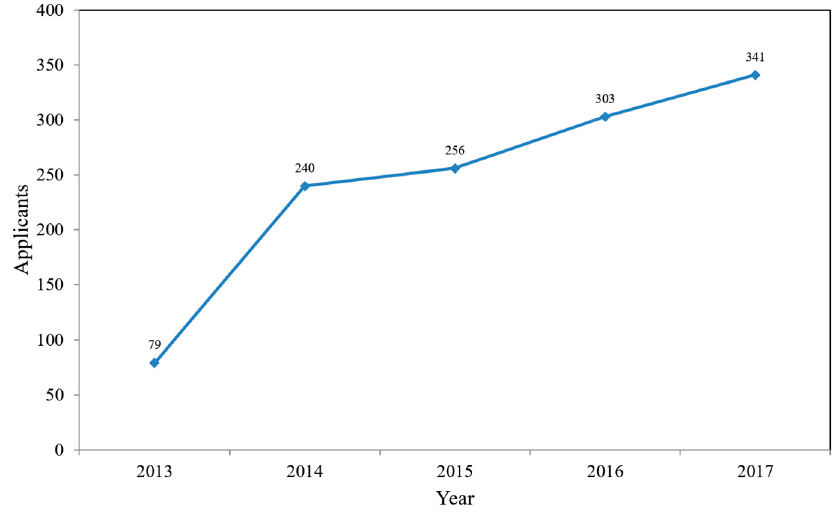
Figure 1. Growth of the number of postpartum home visiting service applicants from 2013 to 2017.